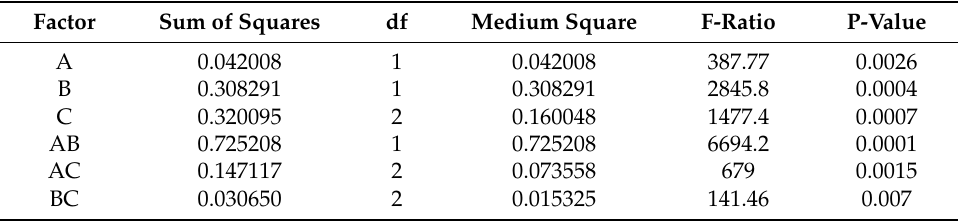
Table 6. Variance analysis summary of the PLA samples with Sg45_b as the optimization response and the factors printing speed (A), layer height (B) and sample thickness